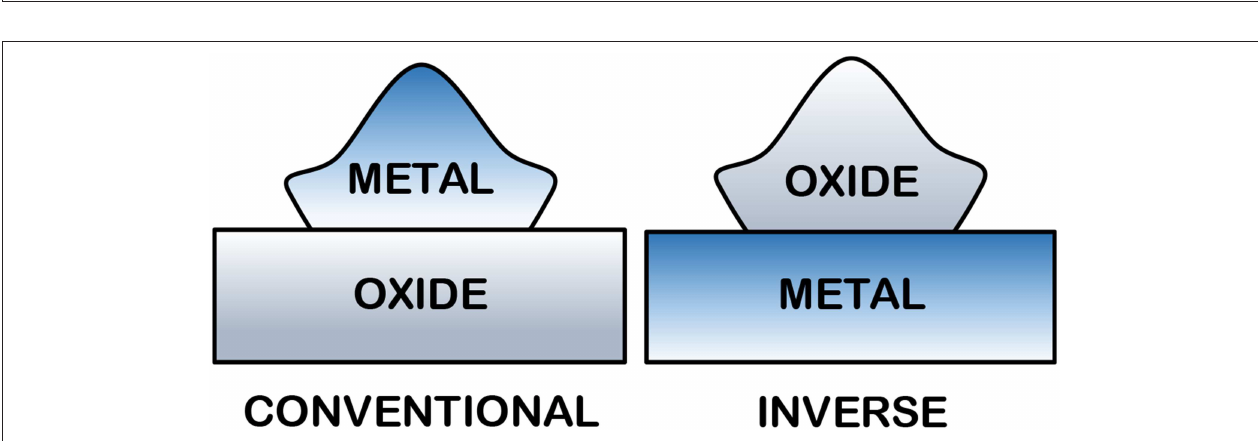
FIGURE 9 | Structure of the conventional and inverted catalysts (adapted Rodriguez et al., 2009; Rodríguez and Hrbek,